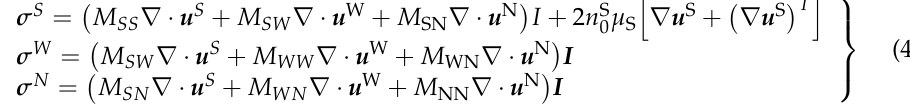
represents the air-entry degree of saturation.